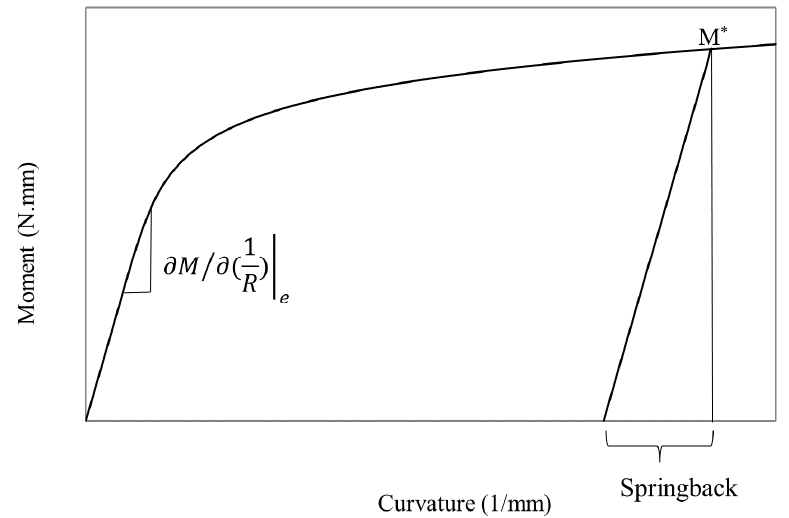
Figure 2. Curvature change of the moment–curvature diagram during elastic unloading.